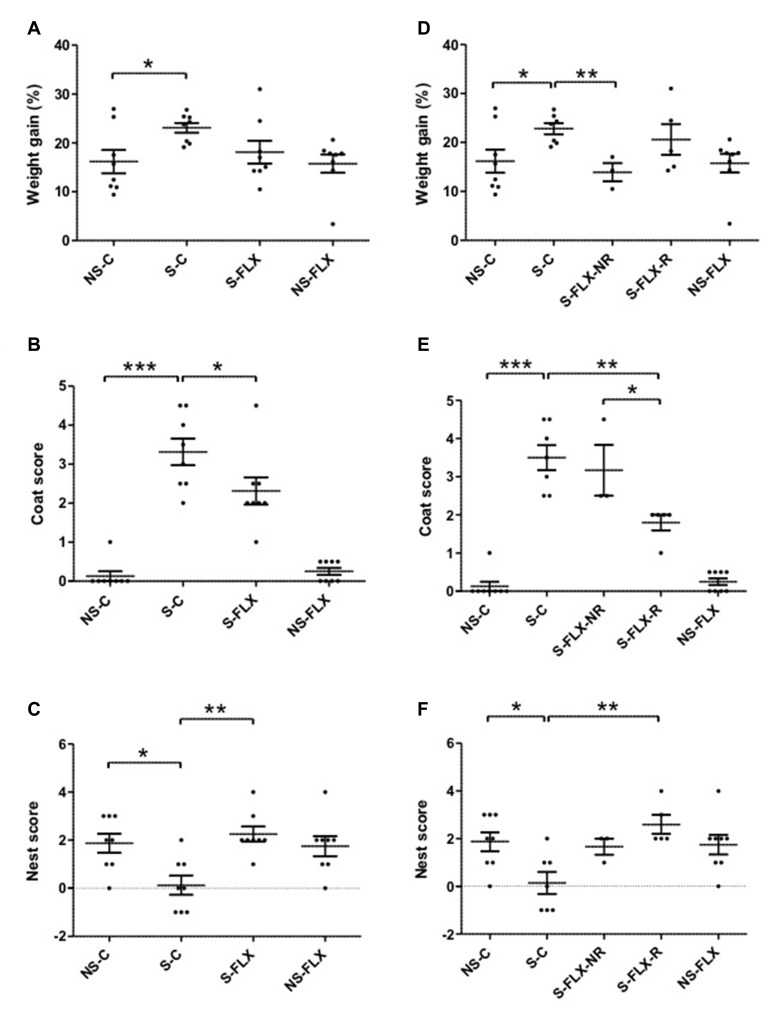
Behavioral tests assessing depressive-like parameters. After 8 weeks of unpredictable chronic mild stress (UCMS) protocol, mice were submitted to several behavioral tests evaluating depressive-like phenotypes. Results are represented as dot plots for the four original mice groups (left panel) or after reclassification according to their responder/nonresponder phenotype (right panel). (A,D) Individual weight variation calculated after UCMS; (B,E) addition of individual coat scores obtained 3 days before sacrifice to the one at the time of sacrifice; (C–F) individual difference between nest building scores obtained after 5 h and 24 h tests. Horizontal bars denote mean values and error bars denote standard error (*P < 0.05, **P < 0.01, ***P < 0.001 using parametric t-test (A,D) or non-parametric Mann-Whitney test (B,C,E,F)). NS, non-stressed; S, stressed; C, vehicule-treated; FLX, fluoxetine-treated; NR, nonresponder; R, responder.